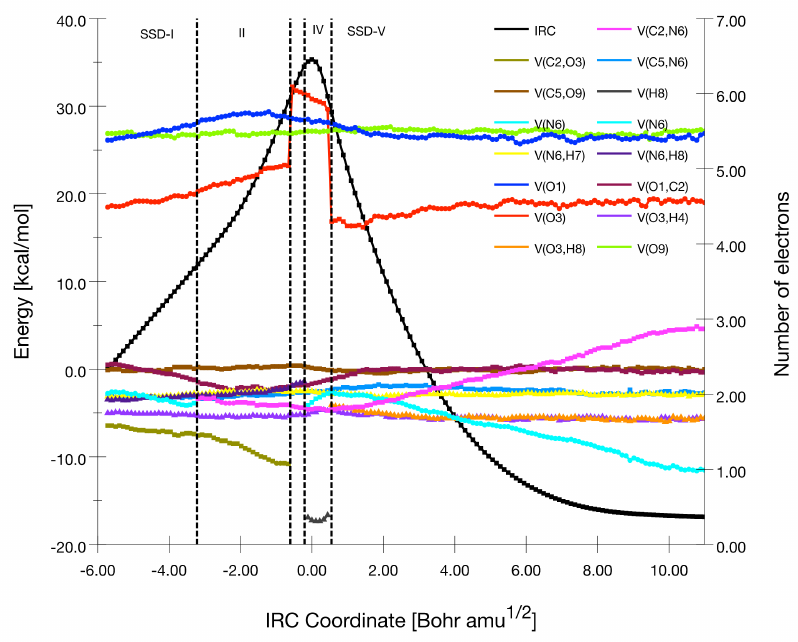
Figure 9. Population evolution (in e) of selected basins along the IRC associated with TS4-a .